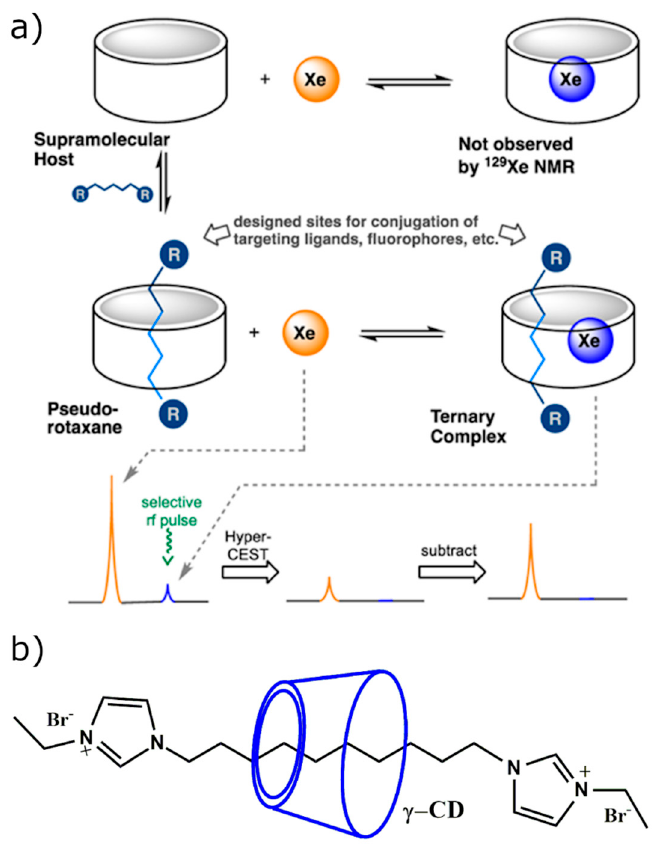
Figure 8. ( a ) Schematic representation of how CD-based ternary complexes are formed in the presence of HP 129 Xe. The guest is threaded through the hydrophobic cavity of cyclodextrin and HP 129 Xe is introduced. Detection via HyperCEST is obtained in order to determine if HP 129 Xe is bound in the cavity of CD. The images are reprinted with permission from publisher [95]. ( b ) The developed cyclodextrin-based pseudorotaxane used for in vitro HyperCEST detection [95].